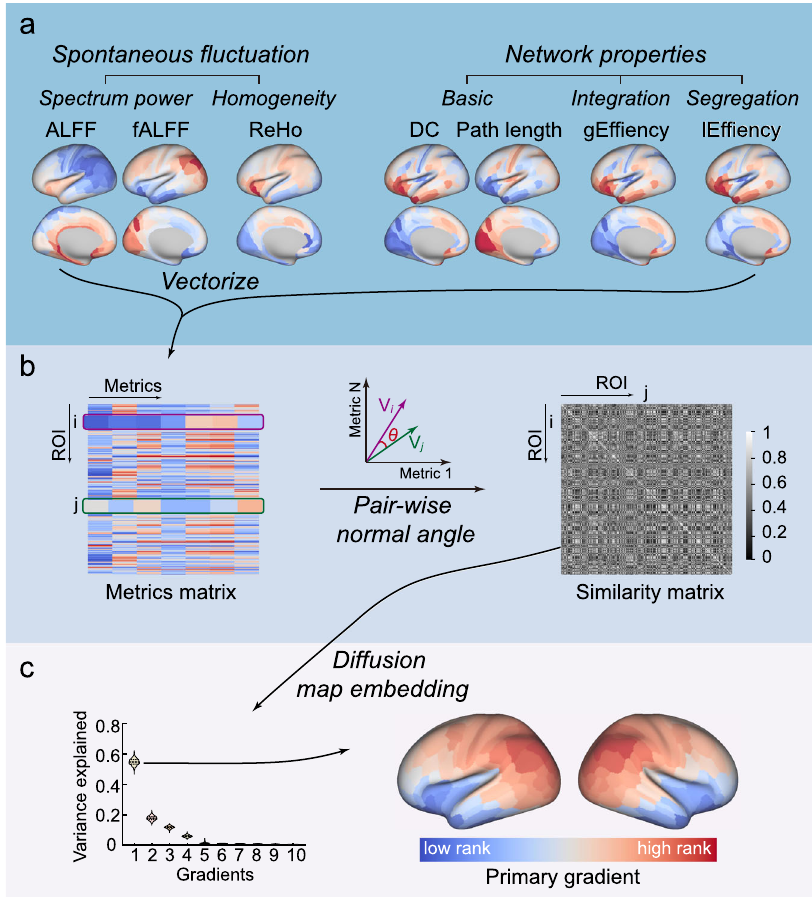
Fig. 1 Schematic diagram of the multifaceted functional gradient. a shows seven metrics derived from the resting-state BOLD-fMRI signal. For each individual, all seven metrics maps vectorized to form a feature matrix, and the normal angle of each pair of brain areas or region of interest was calculated as a similarity measure ( b ). A symmetric similarity matrix resulted from preceding procedures fed into a diffusion map embedding algorithm, to project the high dimensional similarity pro fi le to a series of low dimensional embeddings. The fi rst component of embeddings was selected as the primary gradient because it better explained the half variance of the input similarity matrix and was then rendered in the bottom row on the in fl ated surface ( c